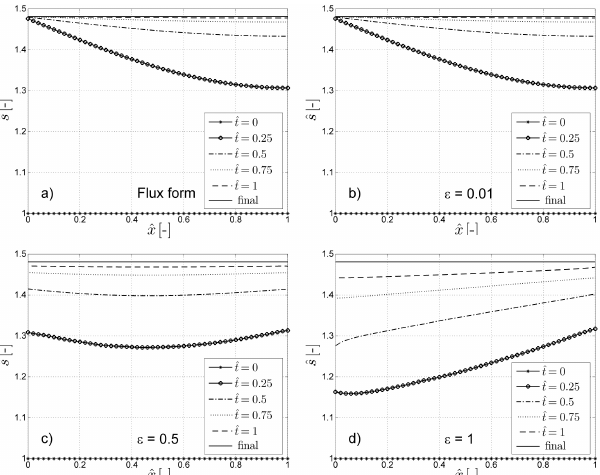
Figure 4. Slope profile evolution for the case ˆ E f = 2: (a) flux form; (b) entrainment form for ε = ¯ r / L d = 0 . 01; (c) entrainment form for ε = 0 . 5; and (d) entrainment form for ε = 1, using the thin-tailed exponential step length function of Eq. (8). In the case of the flux form and the entrainment form with ε = 0 . 01, slope increase is first realized upstream and then propagates downstream in time. For the case ε = 0 . 5, slope more or less increases simultaneously every- where, corresponding to the rotational evolution in Fig. 2c. In the case ε = 1, slope first increases downstream, the e ff ect then gradu- ally propagating upstream in